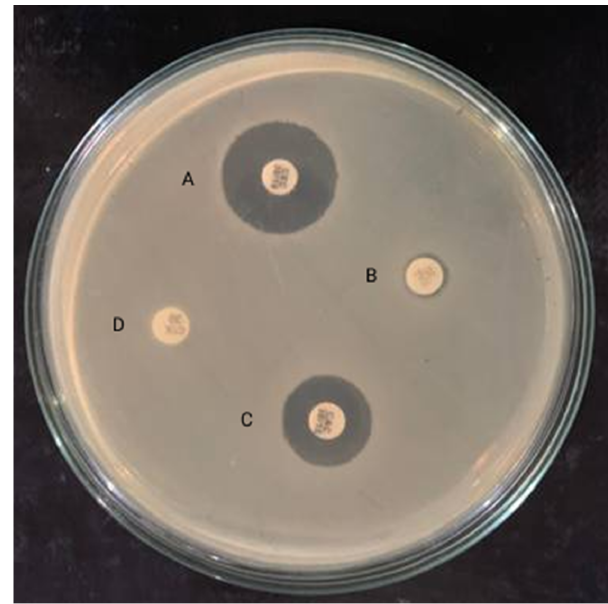
Table 2. Multi-drug resistant (MDR) E. coli -producing Extended Spectrum Beta Lactamase (ESBL). Total E. coli Isolates (%)